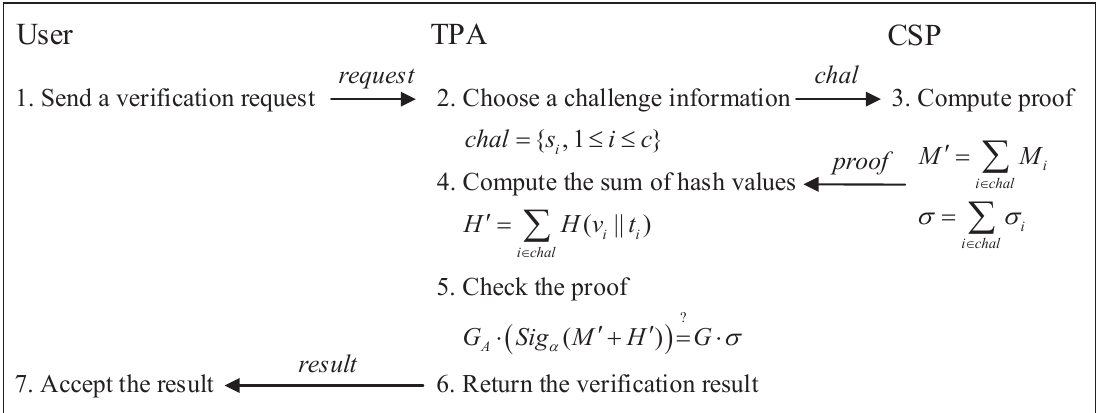
Figure 3. The challenge-verification